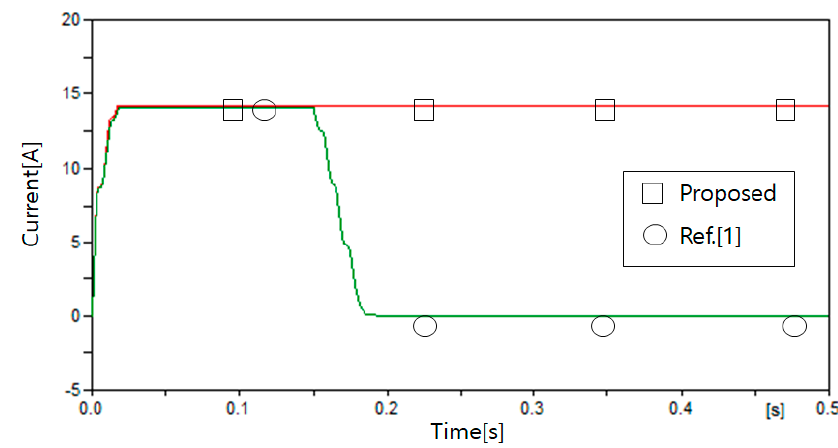
Figure 24. Current measured at Load 6 in Case 6.